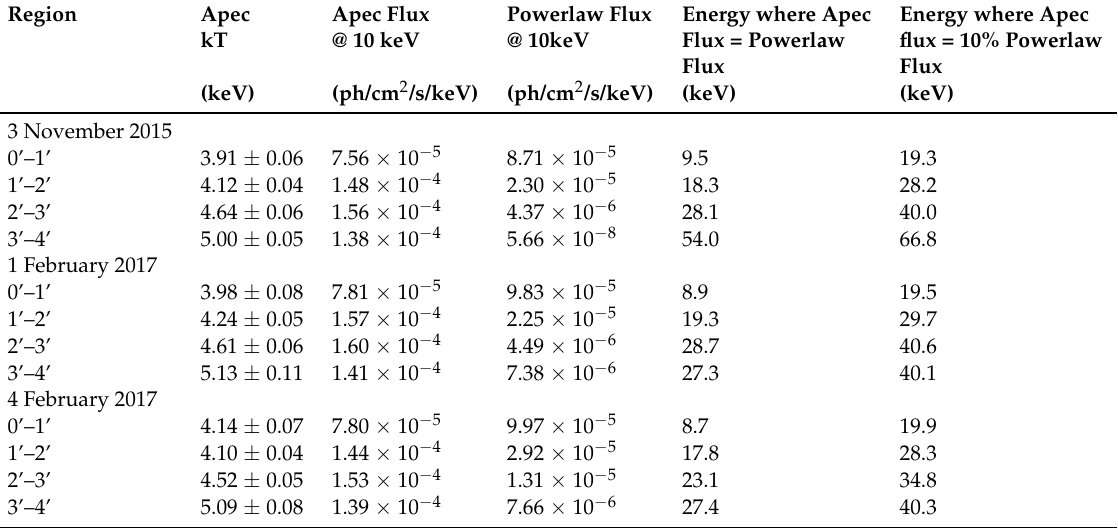
Table 2. Relative contribution to flux from the Perseus cluster and AGN for XRT- NuSTAR combined fit. XRT- NuSTAR combined fit is carried out for 3 November 2015 data whereas for 2017 February observations, only NuSTAR data are